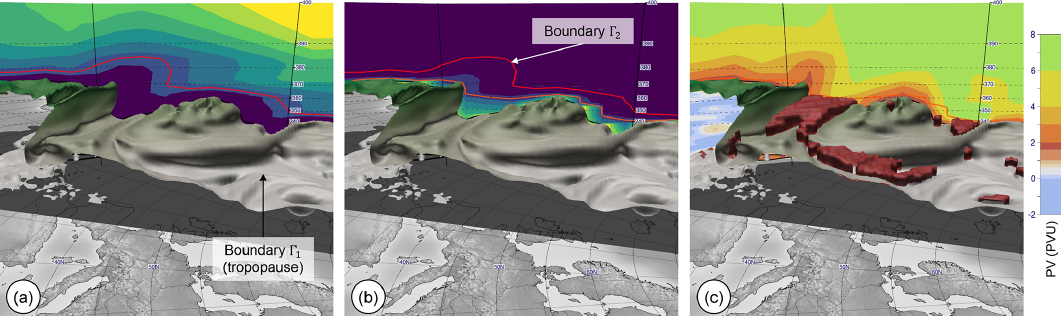
Figure 10. The identification method introduced in Fig. 4 for 2-D extended to 3-D. The tropopause over the North Atlantic (2PVU isosurface) is displayed along with a vertical cross-section showing (a) distances from the dynamical tropopause (boundary (cid:48) 1 ) towards the stratosphere (see Fig. 4d for the 2-D equivalent and the color map), (b) distances measured outwards from the red boundary (cid:48) 2 into the stratospheric domain (see Fig. 4f for the 2-D equivalent and the color map), (c) the potential vorticity. Additionally shown are the identified anomalies on top of the tropopause (red objects). Note that all distances are measured in 3-D, while the visualizations only show a 2-D cross-section. Displayed in all panels is the ERA5 reanalysis on 24 July 2015, 00:00